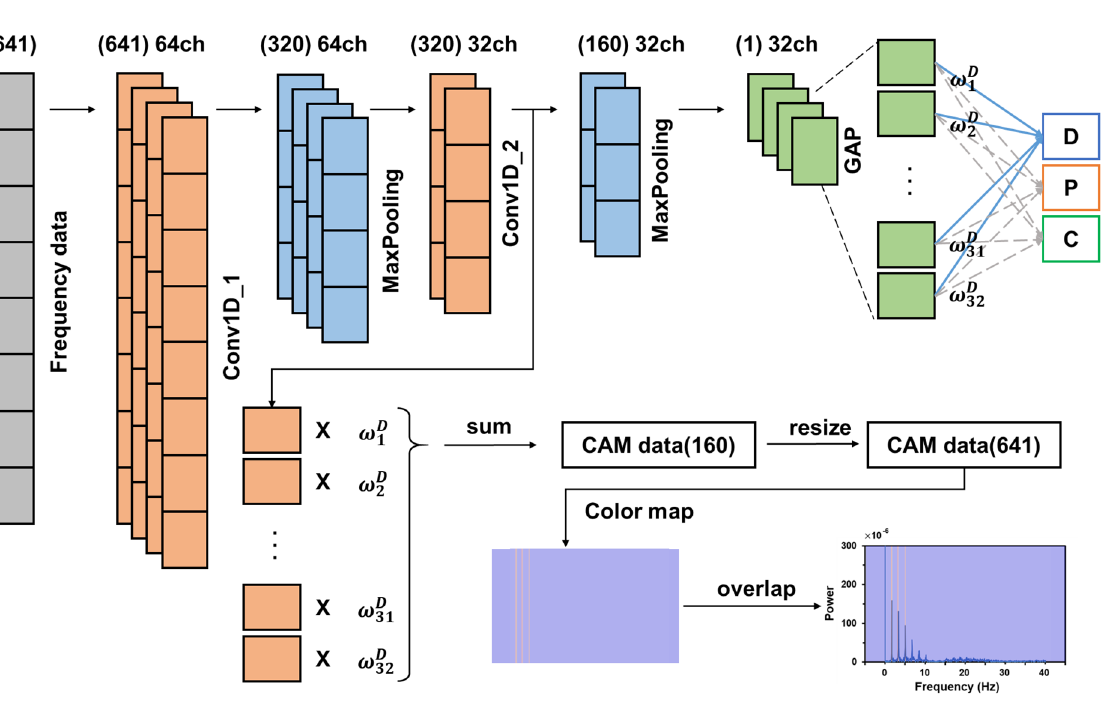
Figure 7. Architecture of CNN with CAM for electrospray mode